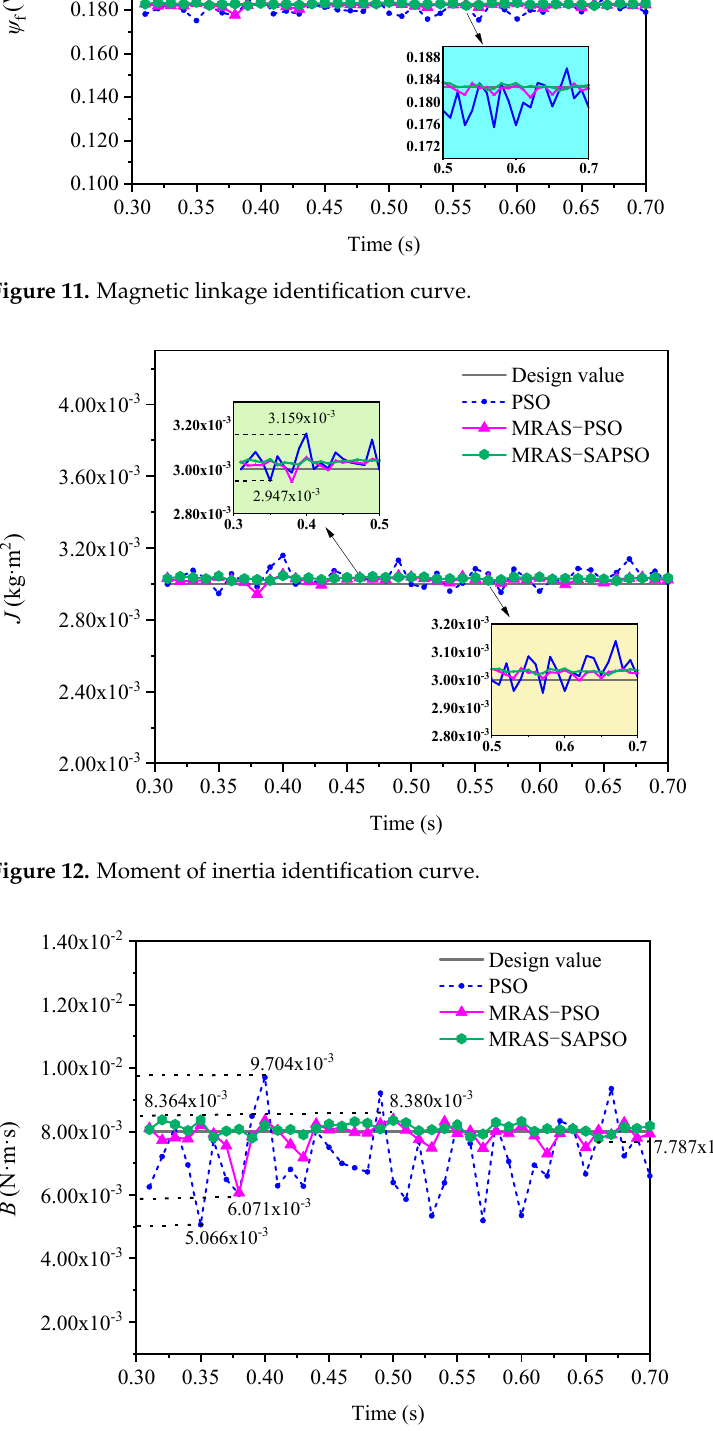
Figure 13. Damping coefficient identification curve.